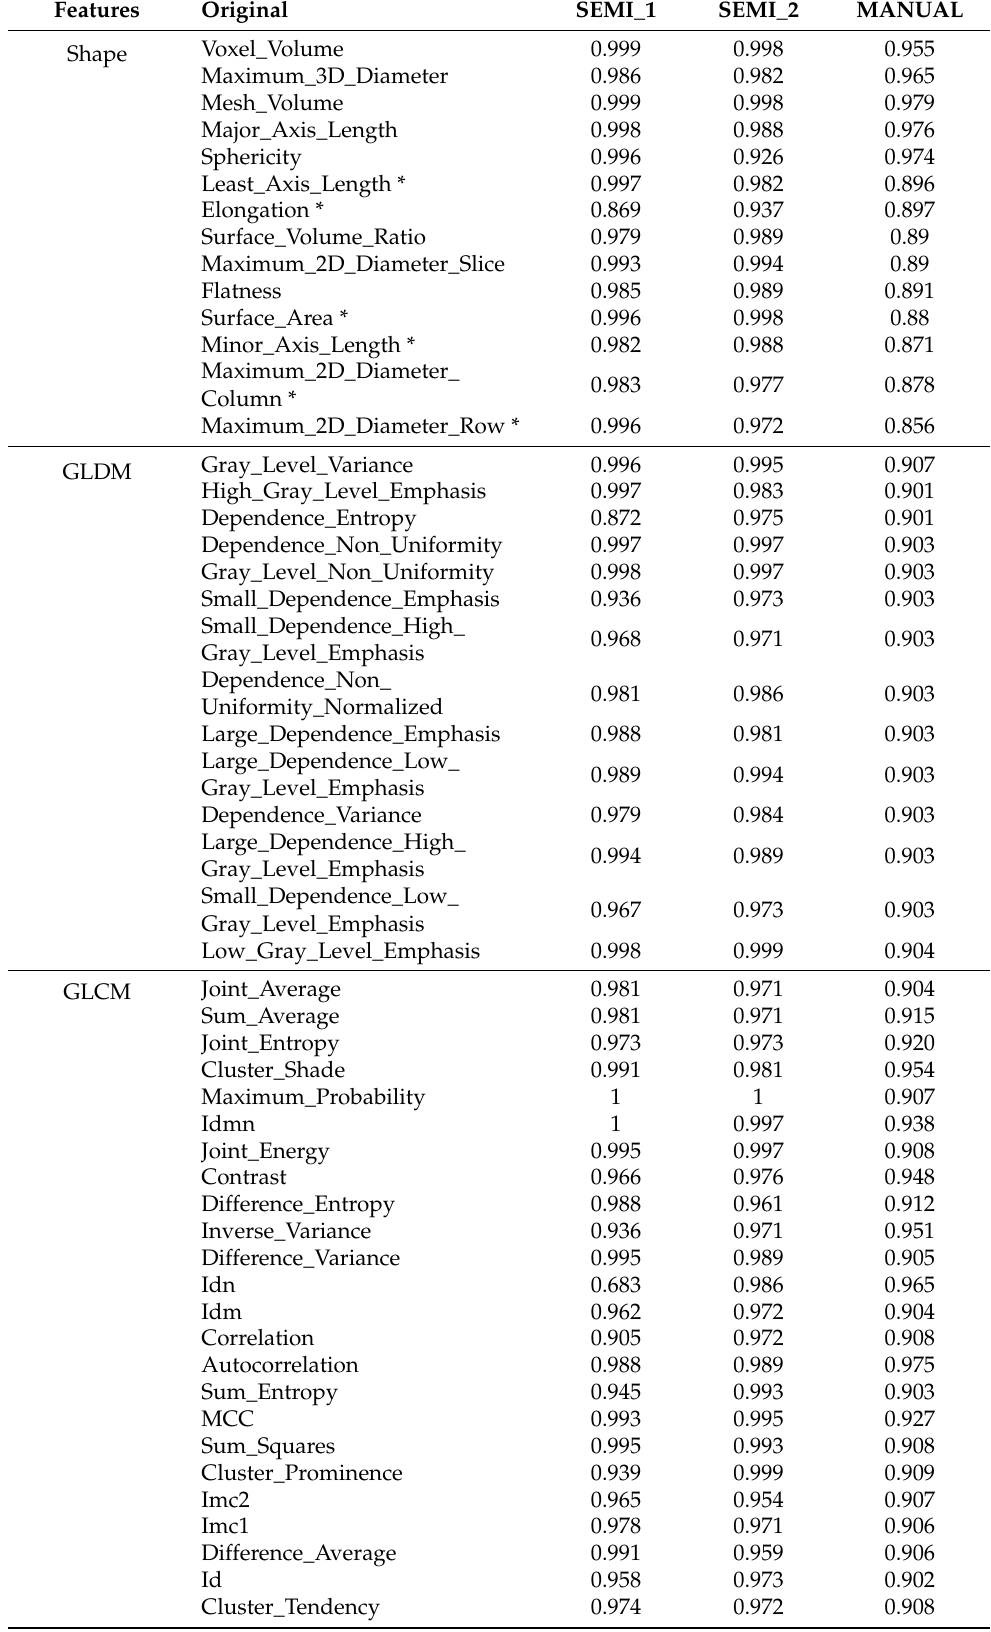
Table 3. Radiomic feature ICC of inter-observer